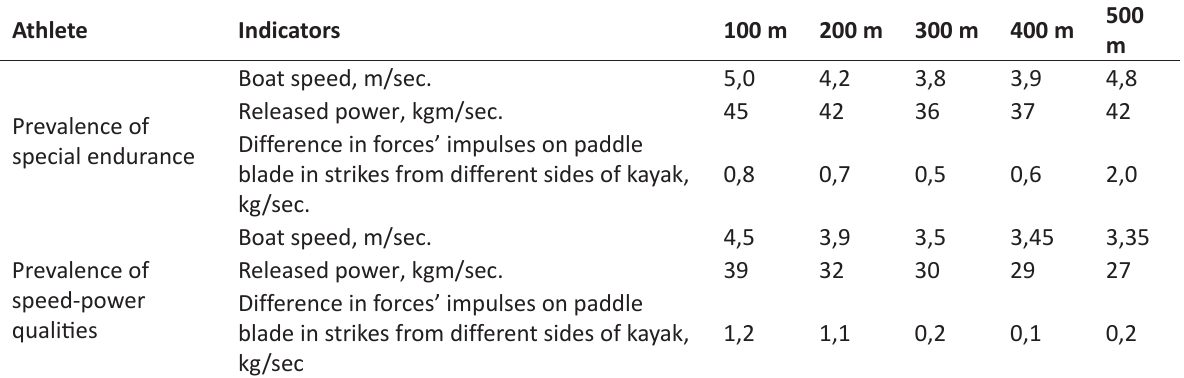
Table 1. Dynamic of special fitness indicators on 500 meters’ distance, passed by athletes with different correlation between speed-power qualities and special endurance